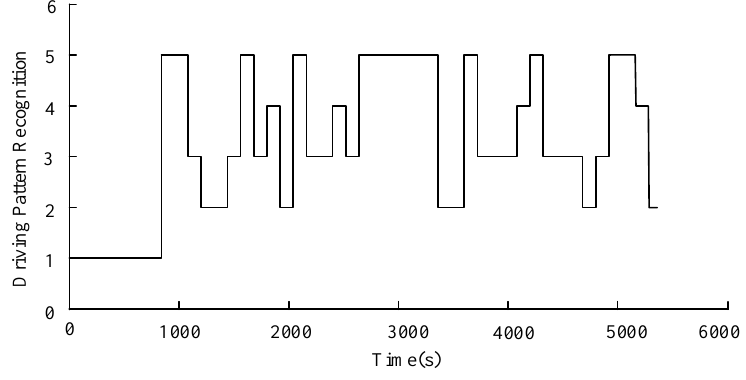
Figure 11. Result of driving pattern recognition under the comprehensive test cycle conditions.